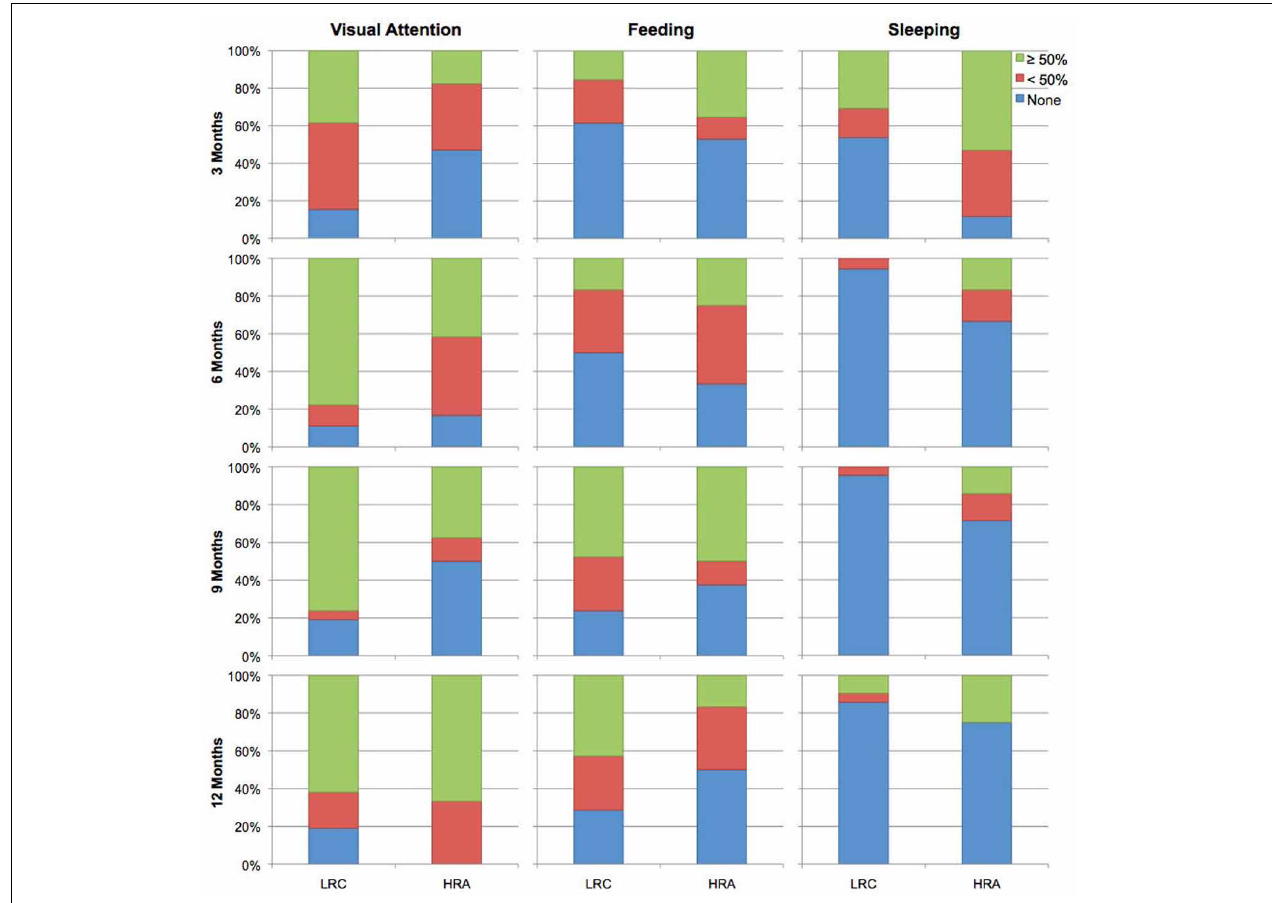
FIGURE 1 | Coded behavioral data for time spent attending to visual stimuli, feeding, and sleeping for LRC and HRA groups at 3-, 6-, 9-, and